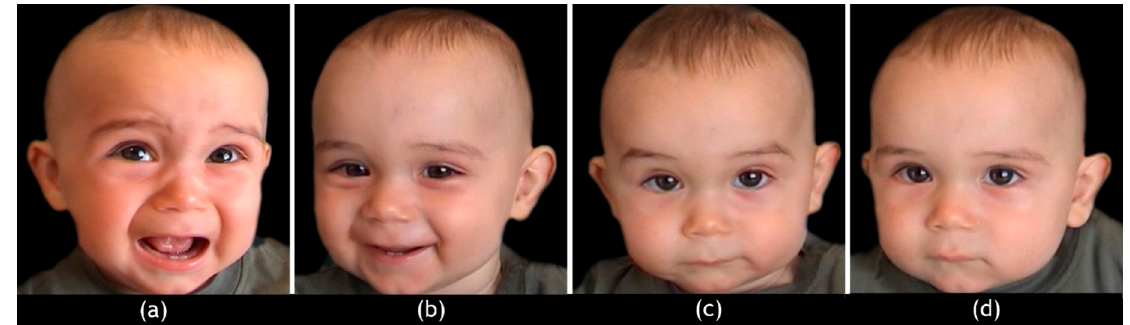
Figure 1. Example of a set of infant facial expressions shown to the parents. (Distress ( a ); Happy emotions ( b ); Ambiguous emotions ( c ); Neutral expressions ( d )).